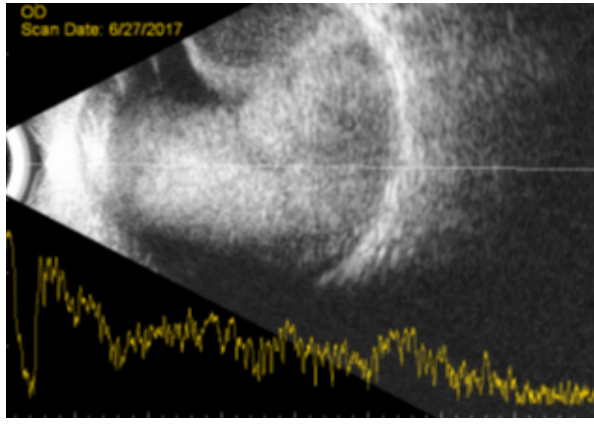
Figure 2: B-scan ultrasound of the left eye showing a Figure 3: Orbital and cranial MRI revealed an intraocular mass withgadoliniumenhancementandlacrimalglandenlargement. No signs of CNS metastasis were